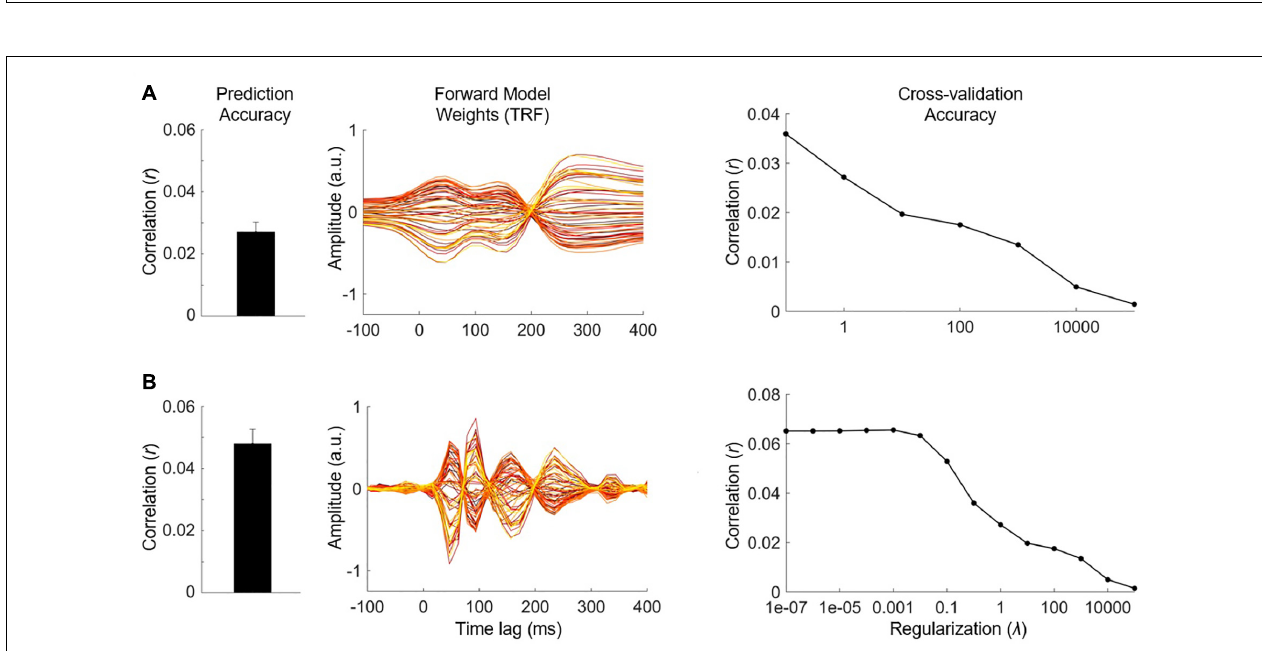
FIGURE 7 | Interpreting TRF weights with sub-optimal regularization. (A) Forward model performance using a limited hyperparameter search in the range [10 − 1 , 10 5 ]. Left, mean prediction accuracy (Pearson’s r ) using optimized regularization parameter, averaged across all EEG channels. Error bars indicate SEM across participants. Middle, optimized TRF weights for individual EEG channels. Darker colors indicate more posterior channels. Right, mean cross-validation accuracy as a function or regularization, averaged across participants. The maximal prediction score corresponded to a lambda value of 10 − 1 . (B) The same data as in panel (A) for a more exhaustive hyperparameter search in the range [10 − 7 , 10 5 ]. This exhaustive search yielded a higher prediction accuracy than in (A) , corresponding to an optimal regularization value of 10 − 3 .